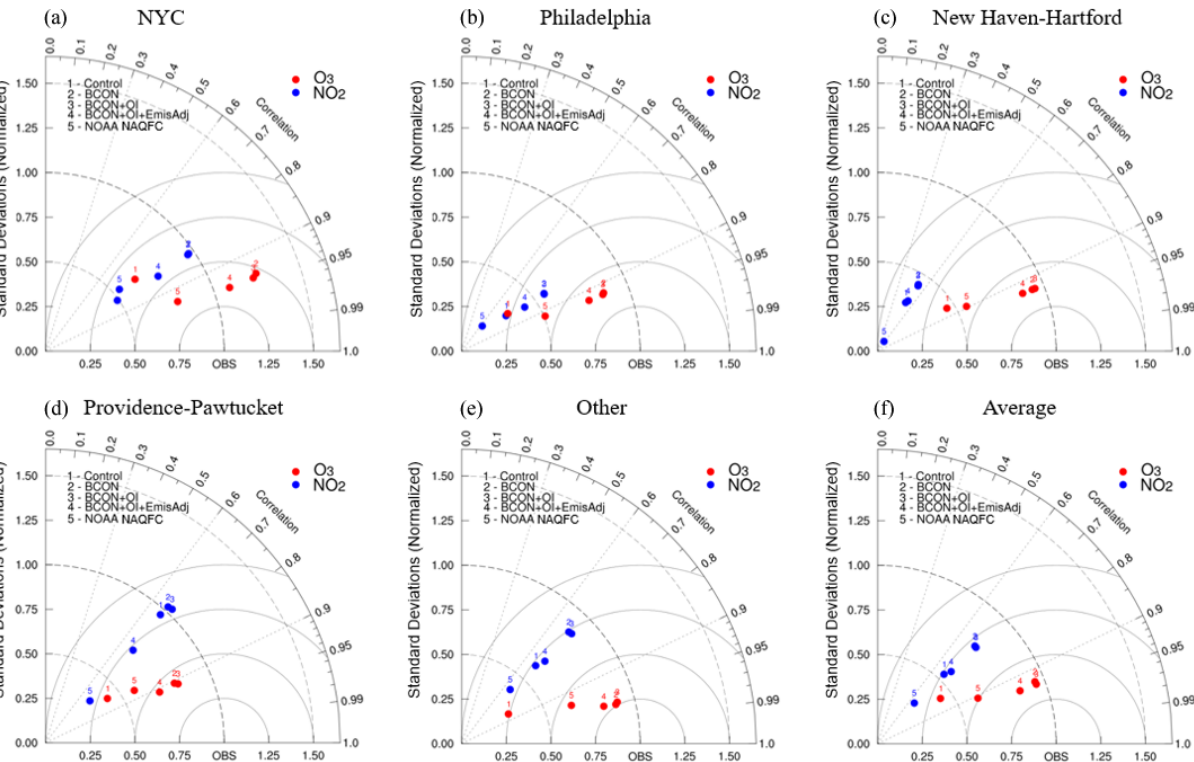
Figure 8. Model performance in Taylor diagrams of hourly O 3 (in red color) and NO 2 (in blue color) simulated by five runs, including the Control run, dynamic boundary conditions (BCON), boundary conditions with optimal interpolation (BCON + OI) and an all-adjustment run including emission adjustment (BOE) and the operational NOAA National Air Quality Forecast Capability (NAQFC) run during the episode over five subdomains and the overall domain (Average). The comparison time is from 26 to 31 August